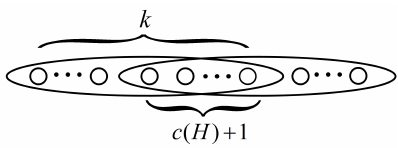
Figure 3. The k -uniform c ( H ) -cyclic hypersubgraph H (cid:48) of H 1